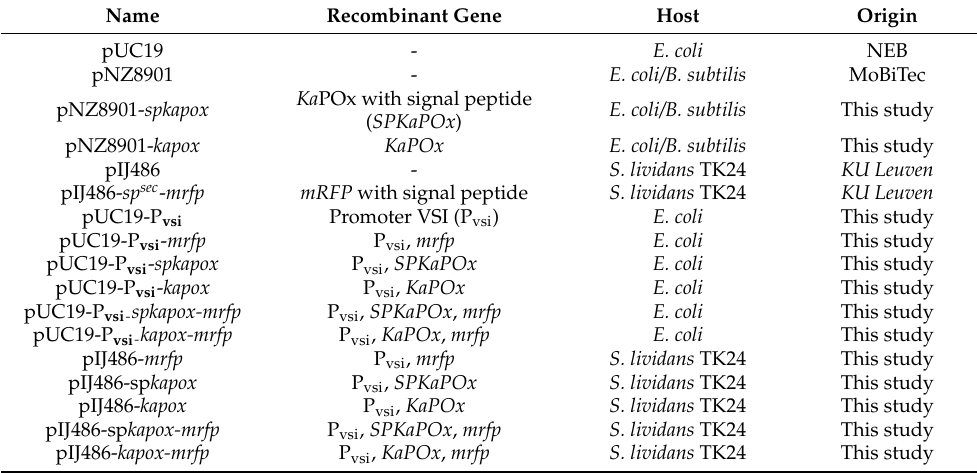
Table 2. Vectors used in this